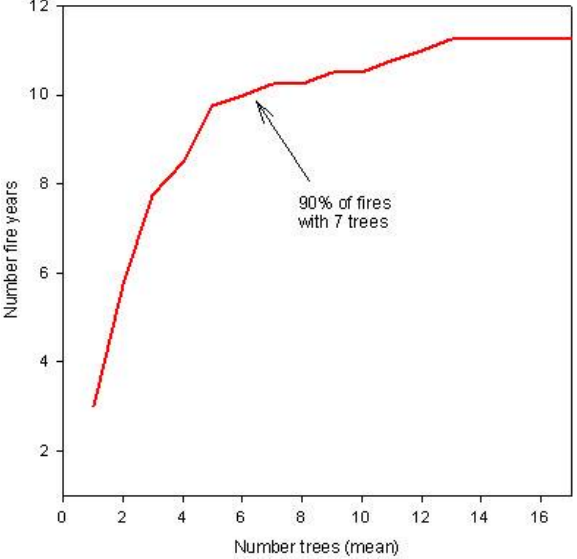
Figure 2. Relationship between the number of trees sampled and new fire years detected based on data collected at the four study sites. The beginning of the asymptote of the curve reflects the minimum sample depth needed in a given area for a high ‐ quality fire scar record.